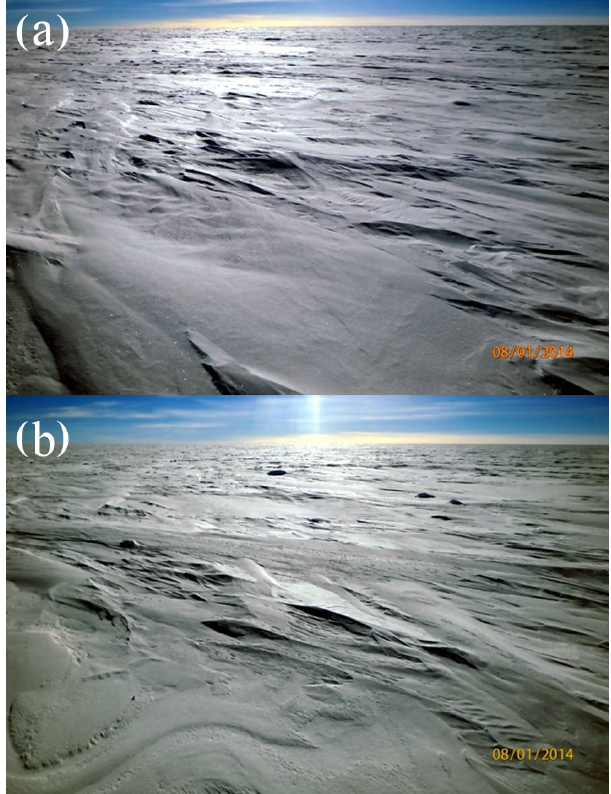
Figure 4. Photo of the snow surface in points MD02: (a) erosion zone, leeward slope of the dune and (b) MD13 deposition zone, the hollow between